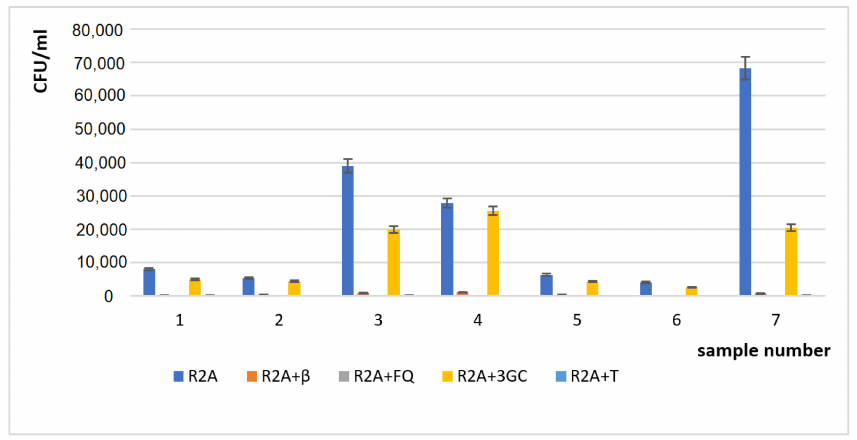
Figure 3. Quantified HPC and ARB, shown as CFU/mL.